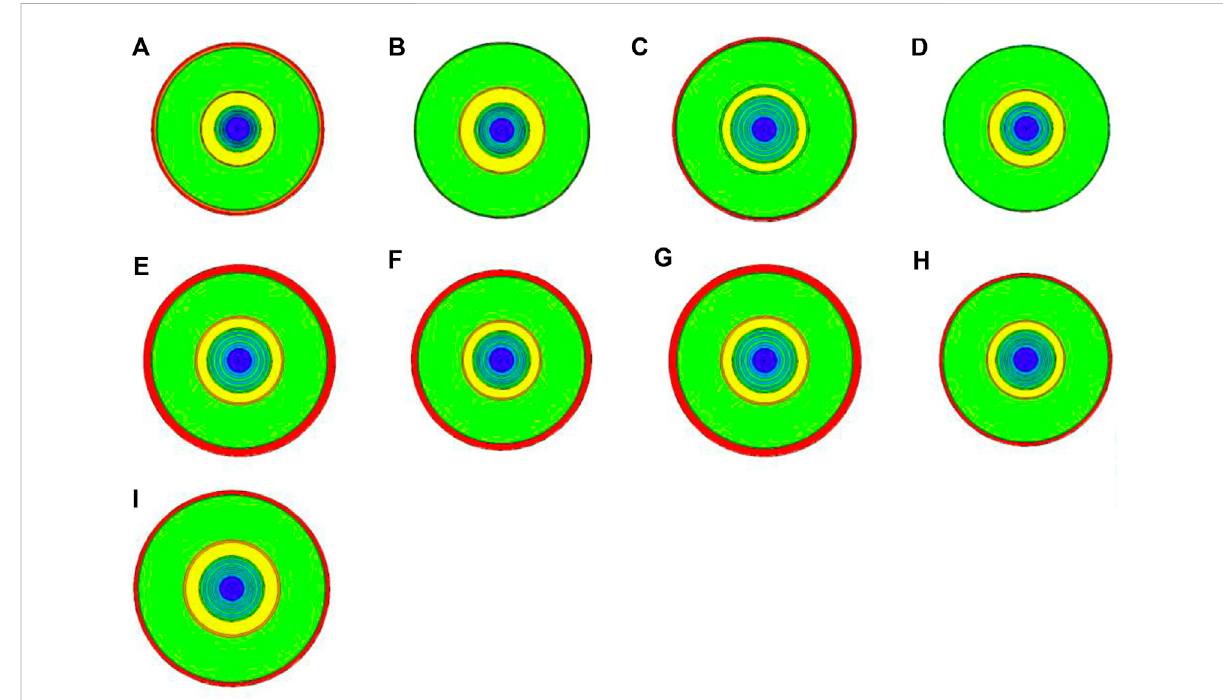
FIGURE 4 Cross-sectionsofthegeometricalstructuresoftheinitialdesignandtypicalindividualsafteroptimization; (A) initialdesign; (B) case1; (C) case2; (D) case 3 with minimal weight; (E) case 3 with minimal dose; (F) case 3 with minimal weight within tolerable limits; (G) case 3 with minimal dose within tolerable limits; (H) case 4 with minimal weight; and (I) case 4 with minimal dose.